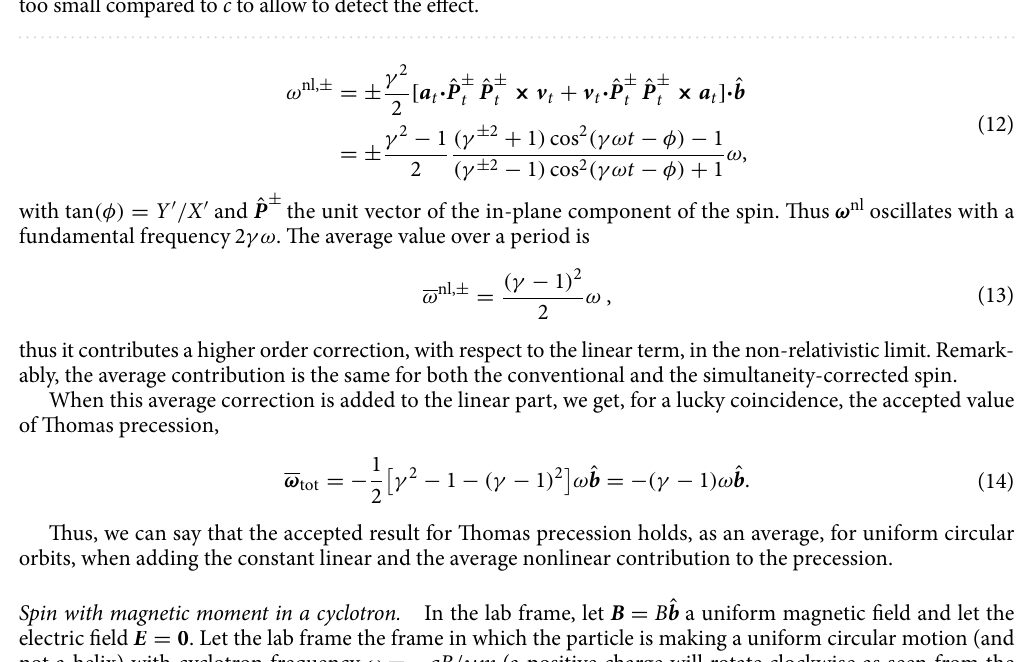
3 c / 5 to make the effect =